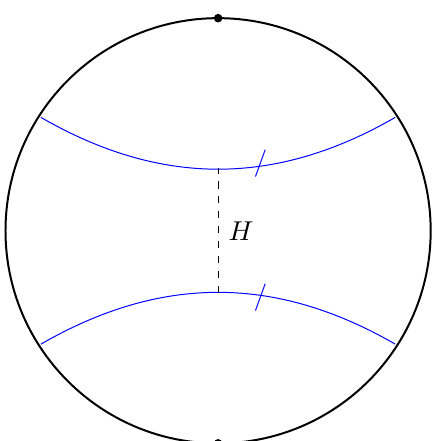
Figure 2. A Cauchy slice of a BTZ black hole shown as a quotient of AdS 3 . The action of γ identifies the two blue geodesics, and the region between them is the fundamental domain of the quotient. The minimal geodesic H separating the two coincides with the event horizon of the black hole. In the non-rotating case, this slice is at t = 0 . But in the case of rotation, there is a relative boost between the two identified